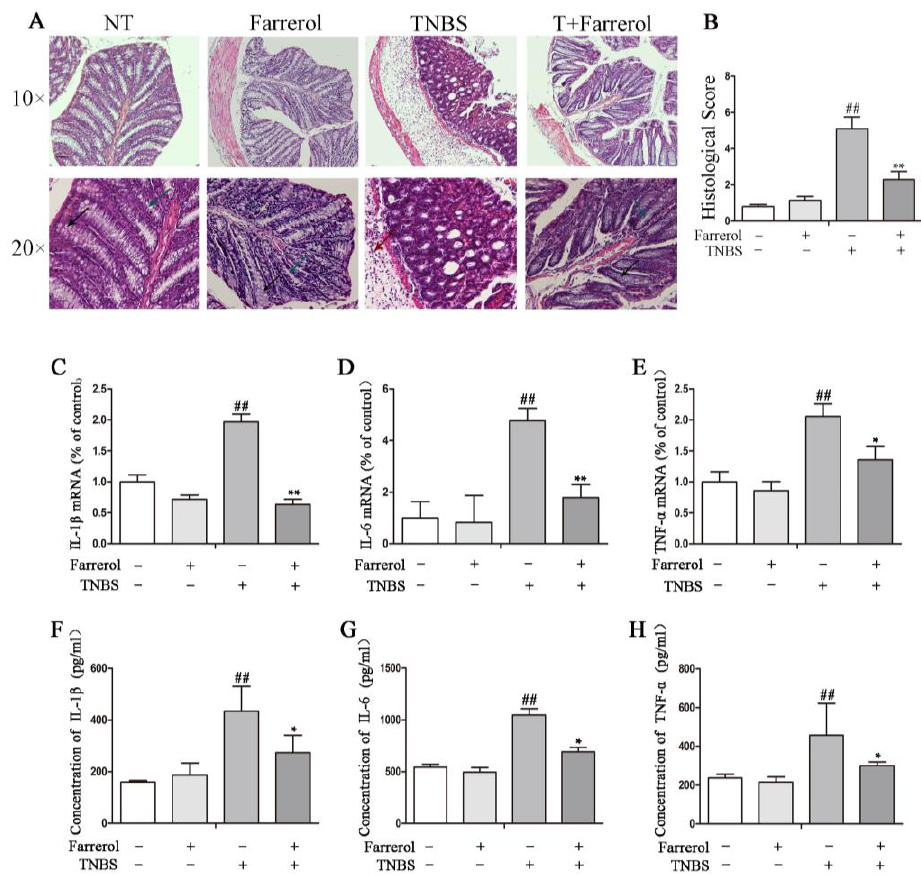
Figure 2. Farrerol inhibits inflammatory response in TNBS-induced mice. ( A ) hematoxylin and eosin (H & E) staining of colonic tissue from mice with different treatment. The black arrow represented goblet cells, green arrow represented crypts and red arrow represented infiltration of inflammatory cells. The scale bar represents 300 μm in 10× , and 100 μm in 20×; ( B ) Histological score of the colon. The gene expression of IL- 1β ( B ), IL-6 ( C ), and TNF- α ( D ) in colonic tissue was examined by quantitative real-time PCR. The protein levels of IL- 1β ( E ), IL-6 ( F ), and TNF- α ( G ) in colonic tissue homogenates were examined by ELISA . n = 10, ## p < 0.01 compared to the control group, * p < 0.05 and ** p < 0.01 compared to the TNBS treatment group, statistical significance was determined by ANOVA.